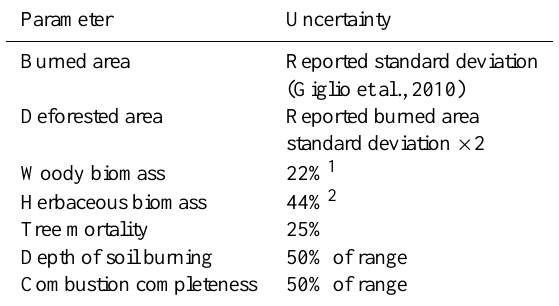
Table 6. Reported and best-guess uncertainties (1 σ) for various parameters influencing fire emission